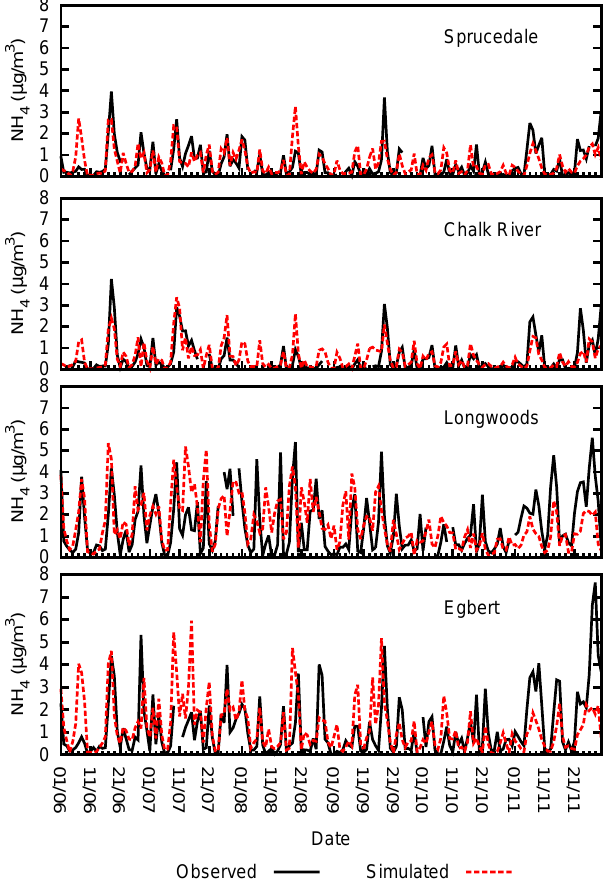
Fig. 5. Modeled (red dash) and measured (black solid) p -NH + h concentrations (µg m − 3 ) for four test sites during the simulation period from 1 June to 30 November